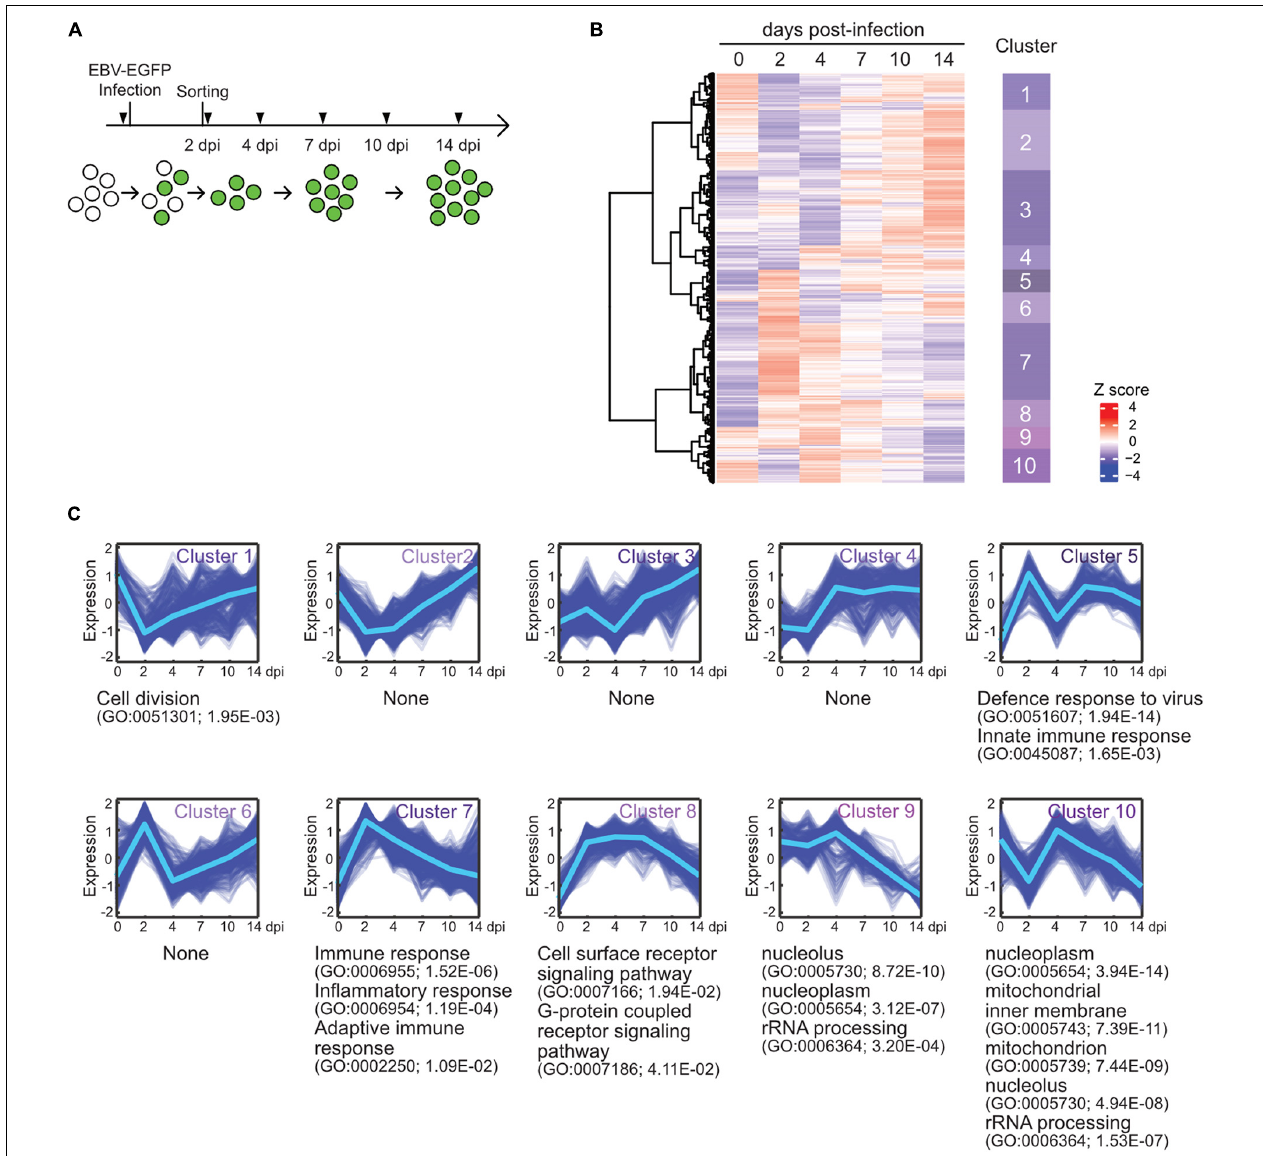
FIGURE 1 | EBV infection caused reprogramming of cell growth. (A) Workflow of sample collection for RNA-seq analysis. Akata(–) cells were infected with EBV-EGFP. The infected cells were collected by FACS sorting at 2 dpi, and portions of infected cells were harvested at the indicated time points (arrowheads). (B) Heat map showing gene expression changes during EBV infection of Akata(–) cells. The 5,000 most diversely expressed genes of both the host and virus are included. Color indicates the normalized expression level ( Z score). Gene clusters are indicated on the right side of the heat map. (C) Temporal changes in gene expression for each cluster. The changes of respective genes (blue) and the mean value (light blue) are plotted. GO enrichment analysis was performed in each cluster, and the representative results (GO terms, GO Ids, and adjusted p -values) are shown on the right side of the